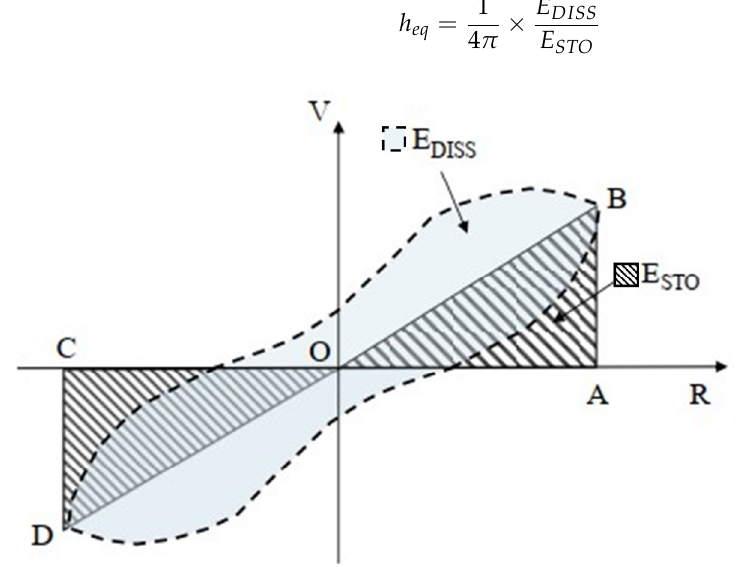
Figure 10. Calculation diagram of the equivalent viscous damping coefficients.